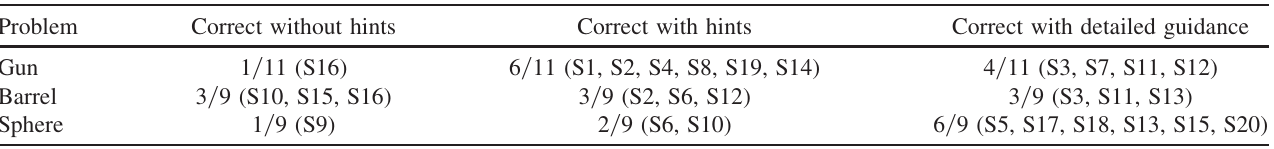
TABLE II. Students who obtained work using the area under the curve without hints, with hints, and with detailed guidance. Problem Correct without hints Correct with hints Correct with detailed guidance Gun Sphere